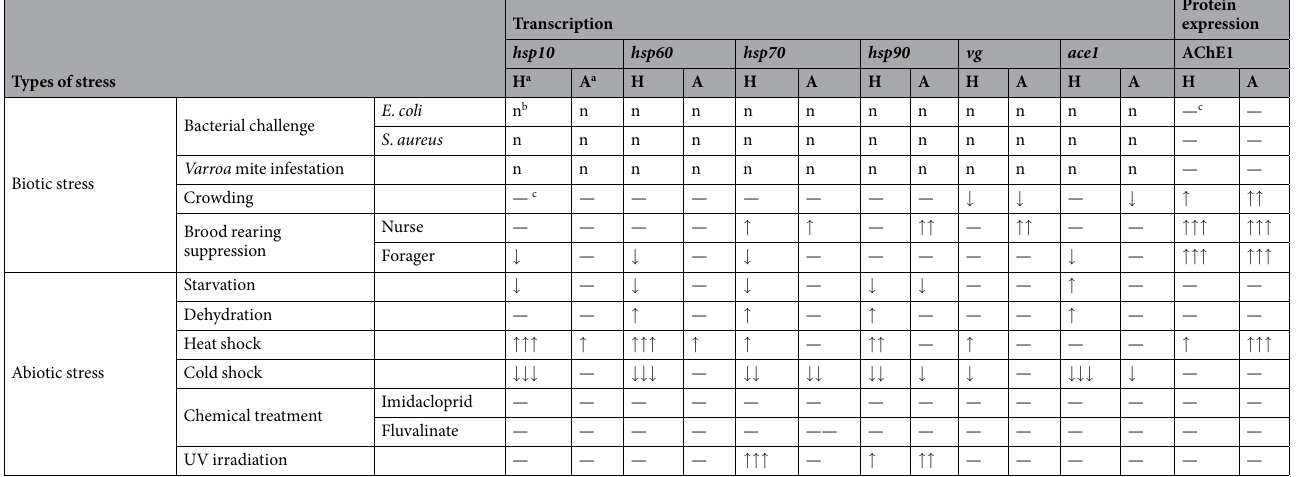
Table 1. Summarized profiles of AmAChE1 expression and stress marker gene transcription following stresses. Differential transcription levels of stress-marker genes following stresses are marked with symbols of ↑ , ↓ ( p < 0.05), ↑↑ , ↓↓ ( p < 0.01) and ↑↑↑ , ↓↓↓ ( p < 0.001), in which the upward ( ↑ ) and downward ( ↓ ) arrows indicate overtranscription and undertranscription, respectively, compared to the control. The degree of AmAChE1 expression is marked with ↑ , ↑↑ and ↑↑↑ depending on band intensity following Western blotting. a The letters H and A represent the head and abdomen samples, respectively. b The letter ‘n’ indicates no investigation. c The symbol ‘—’ indicates that no difference. in either protein expression or transcription was